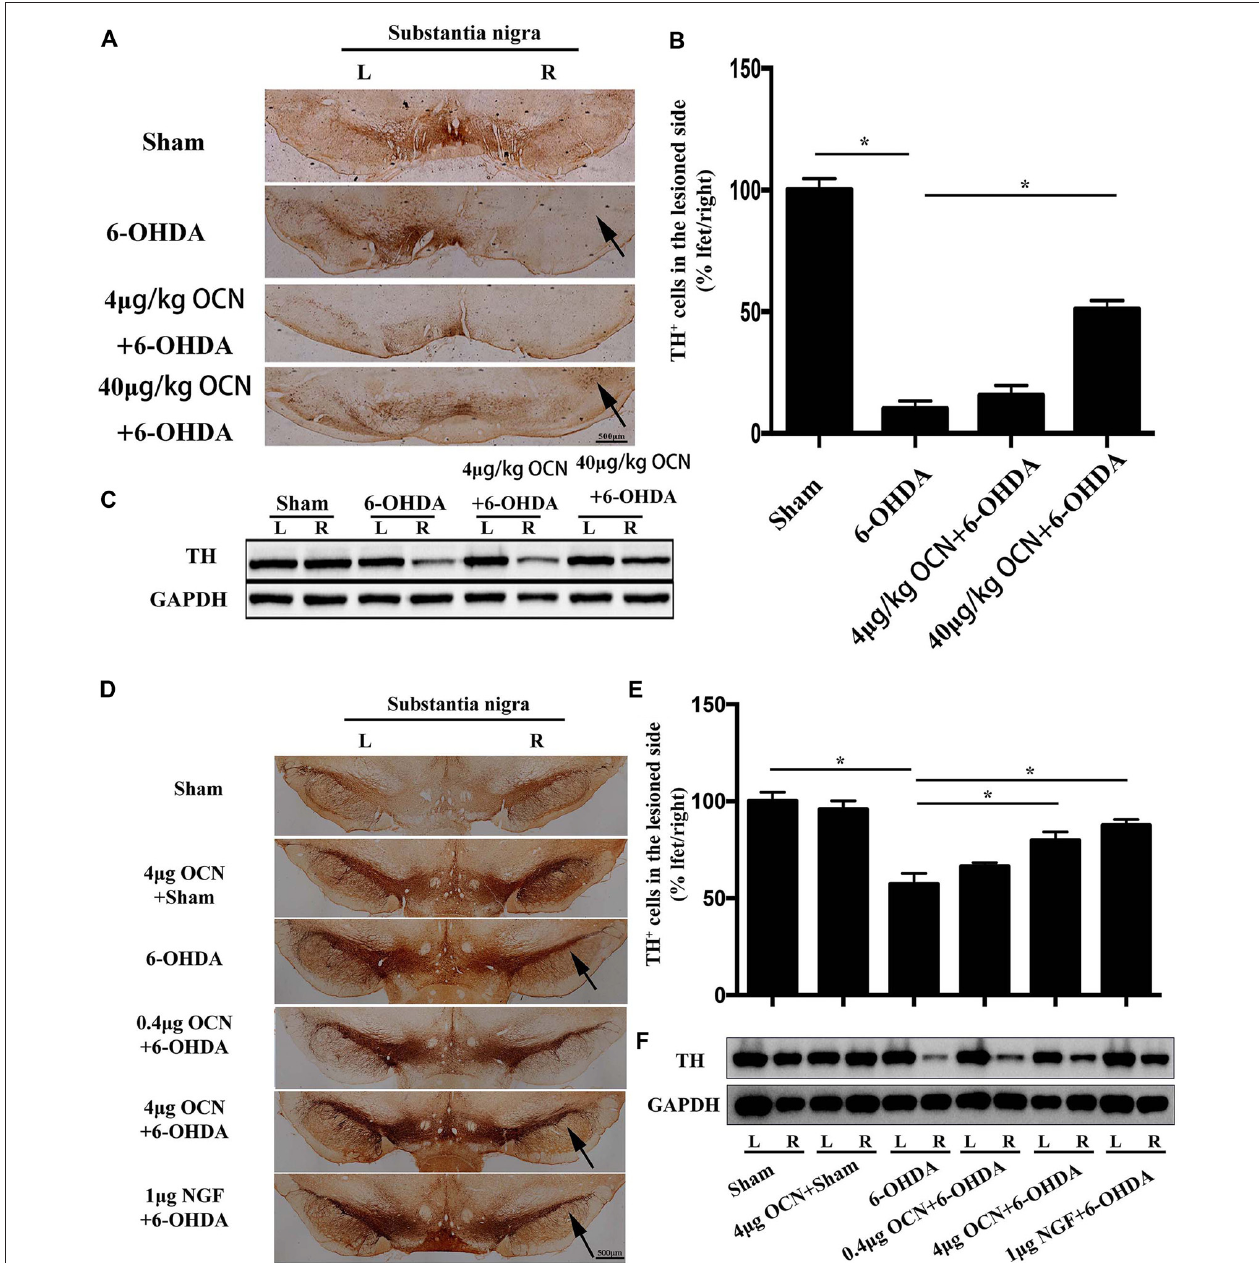
FIGURE 4 | The protective effect of OCN on tyrosine hydroxylase (TH + ) neurons and fibers in the nigrostriatal system in the unilateral 6-OHDA-lesioned PD rat model. 6-OHDA induced ∼ 90% dopaminergic neuronal loss on the lesioned side compared to the intact side of the substantia nigra (SN), which was improved by i.p. OCN injection (A) . Similarly, the decrease in TH-positive cell number in the SN of the lesioned side was also significantly alleviated by OCN injection (B) . The results from western blots measuring TH were consistent with immunohistochemistry in the striatum (C) . In the intra-striatum injection OCN group, 6-OHDA induced ∼ 50% dopaminergic neuronal loss in the lesioned side compared to the intact side of the SN, which was improved by OCN injection (D) . Similarly, the decrease in TH-positive cell number in the SN of lesioned side was also significantly alleviated by intra-striatum OCN injection (E) . The results from western blots measuring TH were consistent with immunohistochemistry in the striatum (F) . n = 16, ∗ P < 0.05 (compared with the 6-OHDA group).